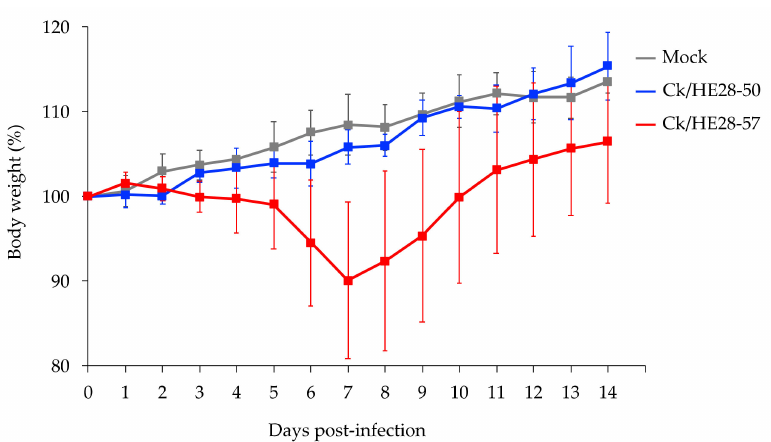
Figure 3. Body weight changes in mice infected with H9N2 avian influenza viruses. Five mice per group were intranasally inoculated with 10 6 PFU (in 50 µ L) of Ck/HE28-50, Ck/HE28-57, or PBS as a control. Body weights were measured daily for 14 days and are presented as means ±